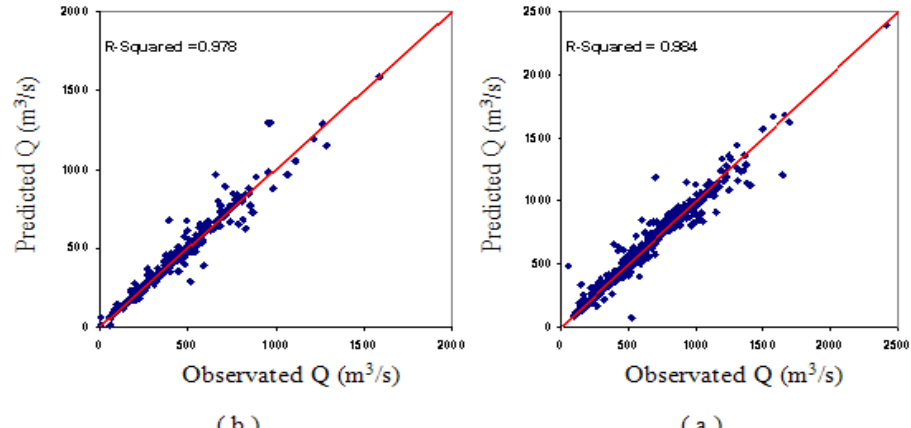
Fig. 7 Observed discharge versus predicted discharge for model 4: a) training data, b) testing